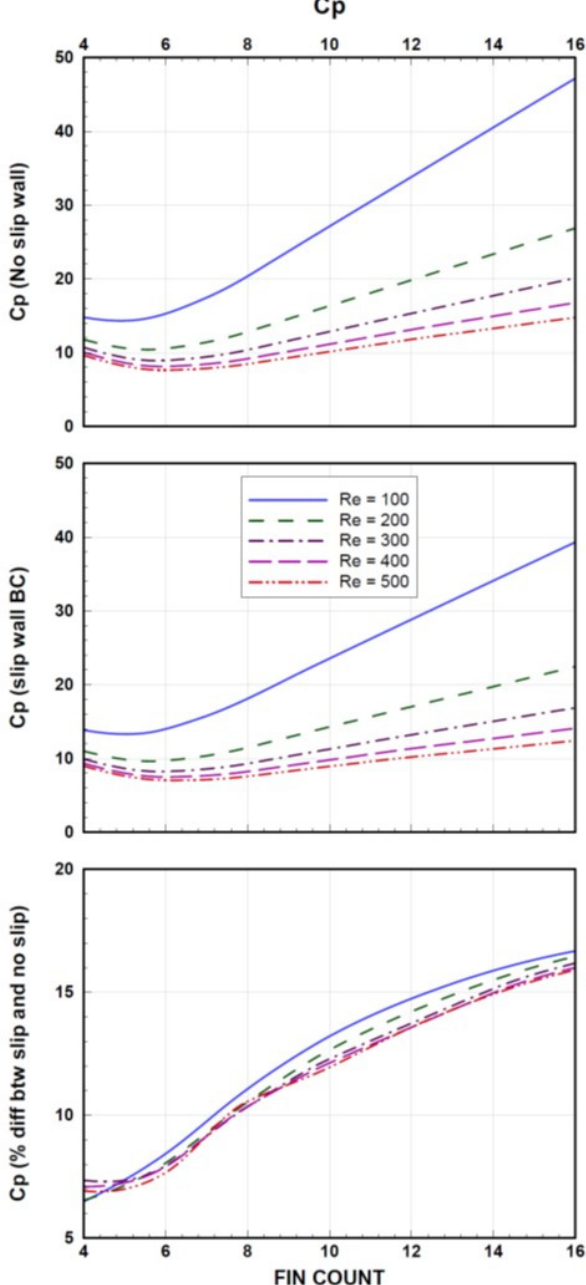
Figure 10. Pressure coefficient with fin counts for various Reynolds numbers and hydrophilic and hydrophobic fin surfaces. % difference of temperature parameter is also given for comparison.